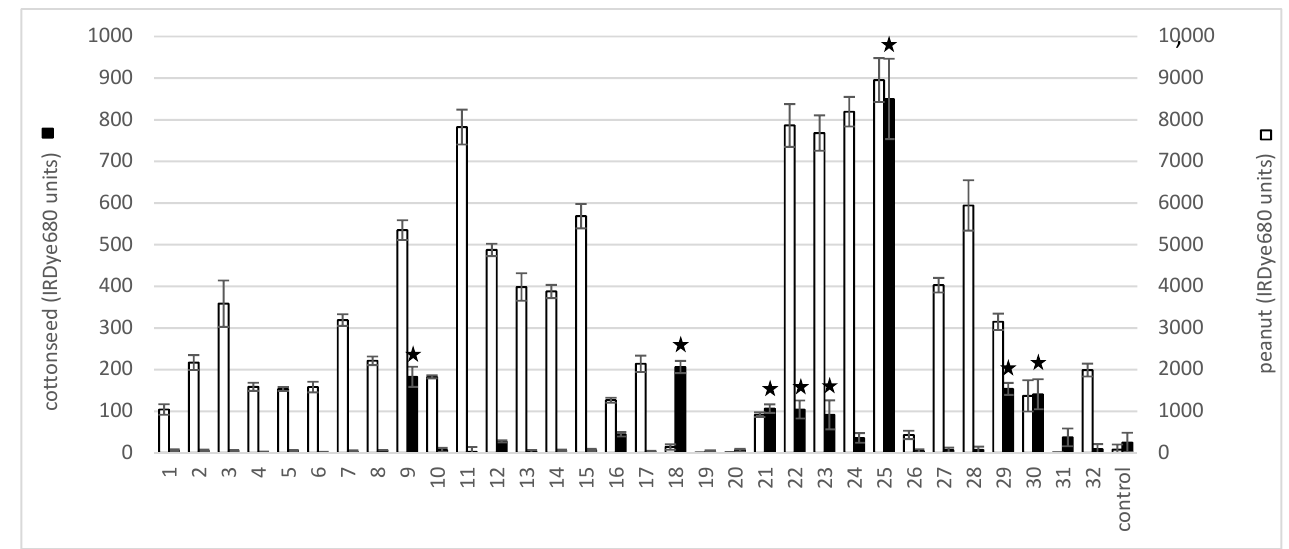
Figure 1. Glandless cottonseed protein cross-reacts with peanut and tree nut allergic volunteer IgE. ELISA binding to Gl cottonseed or peanut proteins was evaluated with peanut and tree nut allergic volunteer sera. IRDye680 units representing IgE binding to cottonseed protein (black bars) are indicated on the left side Y -axis and IgE binding to peanut protein (white bars) on the right side y -axis. Volunteer number is indicated on the X -axis. Data represents the average of at least four replications per sample with standard deviation shown as ± error bars. Bars with stars over them indicate values greater than two standard deviations above the mean. Table 1. ImmunoCAP Values for Peanut and Tree Nut Allergic Samples.